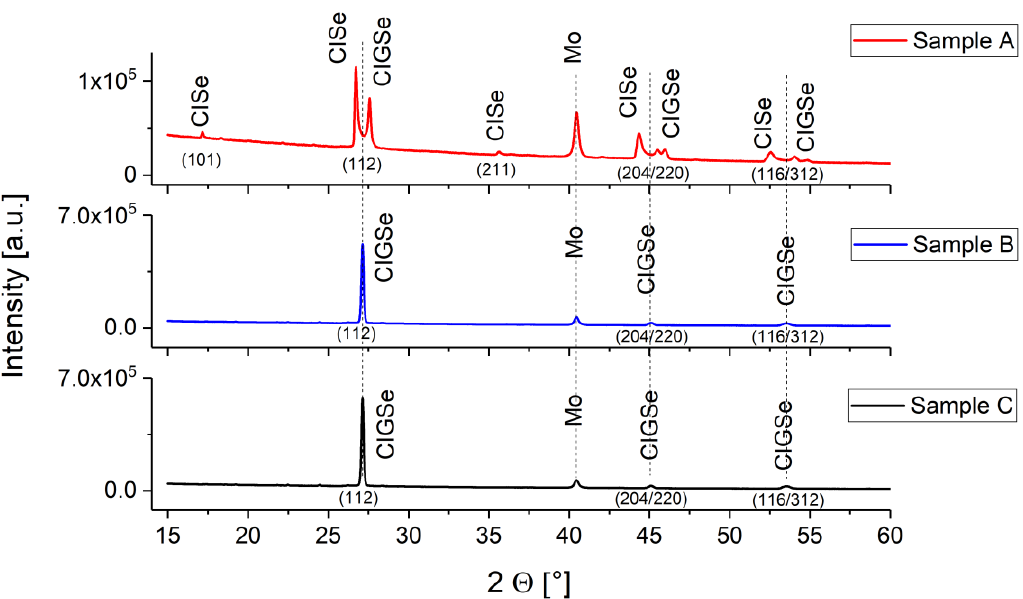
Figure 1. X-ray diffraction measurements on samples A, B, and C.